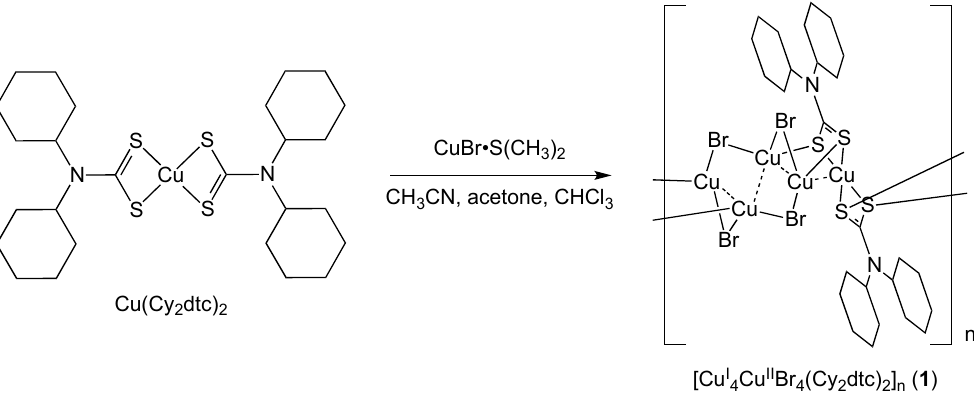
Scheme 1. Synthesis of 1D coordination polymer 1 by the reaction of copper(II) dithiocarbamate